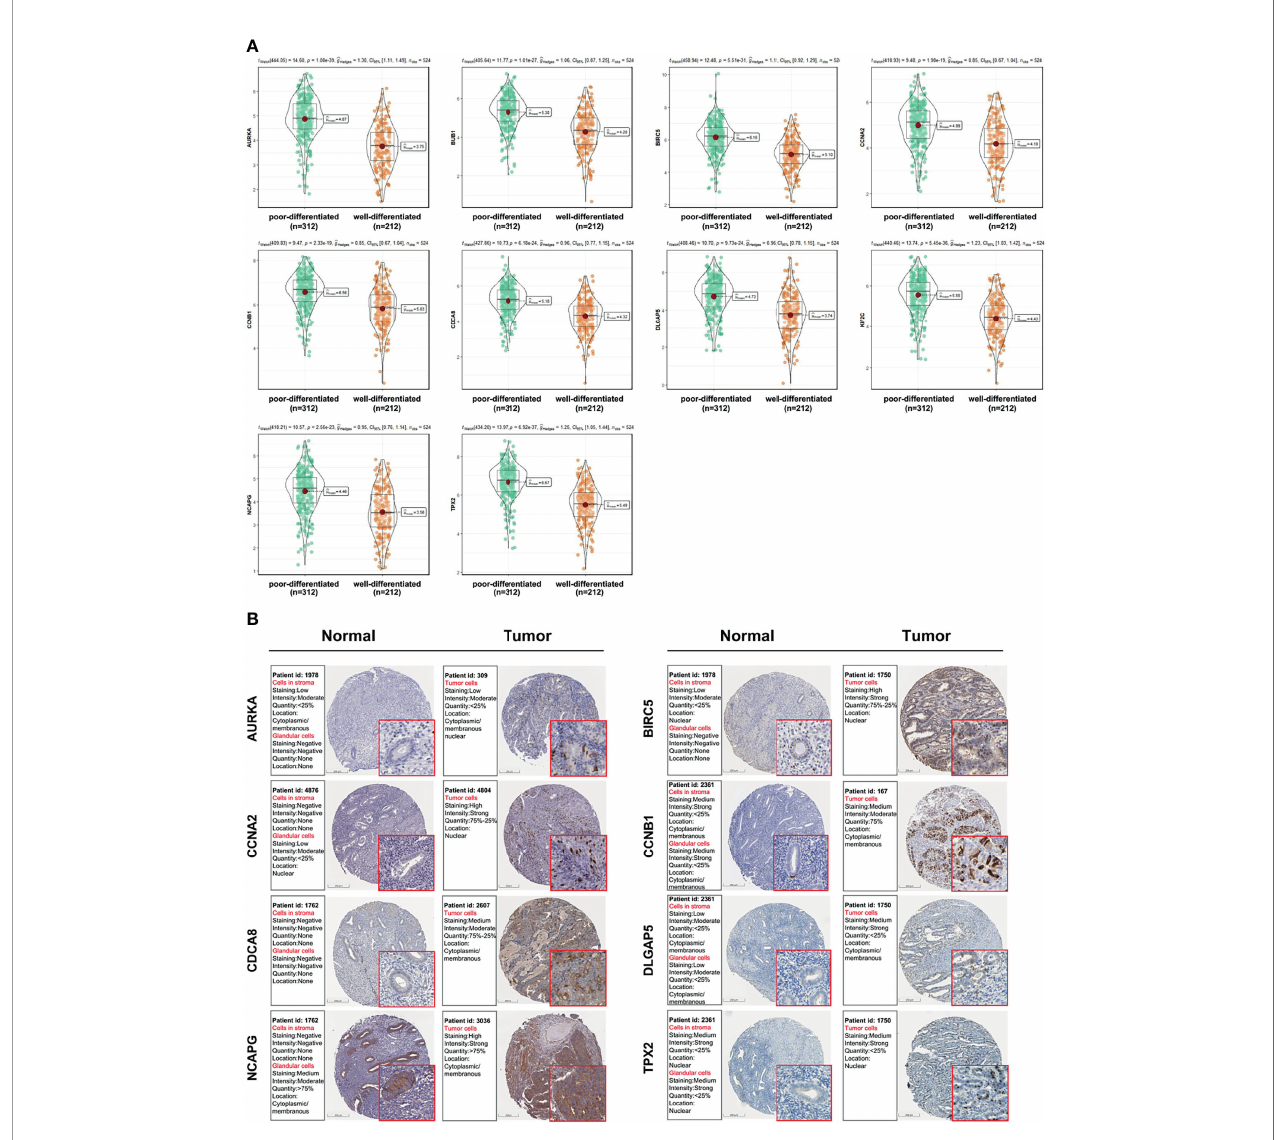
FIGURE 6 | Analysis of the expression patterns of candidate genes (AURKA, BIRC5, BUB1, CCNA2, CCNB1, CDCA8, DLGAP5, KIF2C, NCAPG and TPX2). (A) The expression levels of candidate genes between poorly and well-differentiated UCEC in the TCGA dataset. (B) The protein expressions of candidate genes between UCEC tissues and non-tumorous tissues based on the Human Protein Atlas database. Most of these genes were higher in UCEC tissues compared to non-tumorous tissues, except that no protein expression was detected for KIF2C gene and there was no expression data for BUB1 gene in this